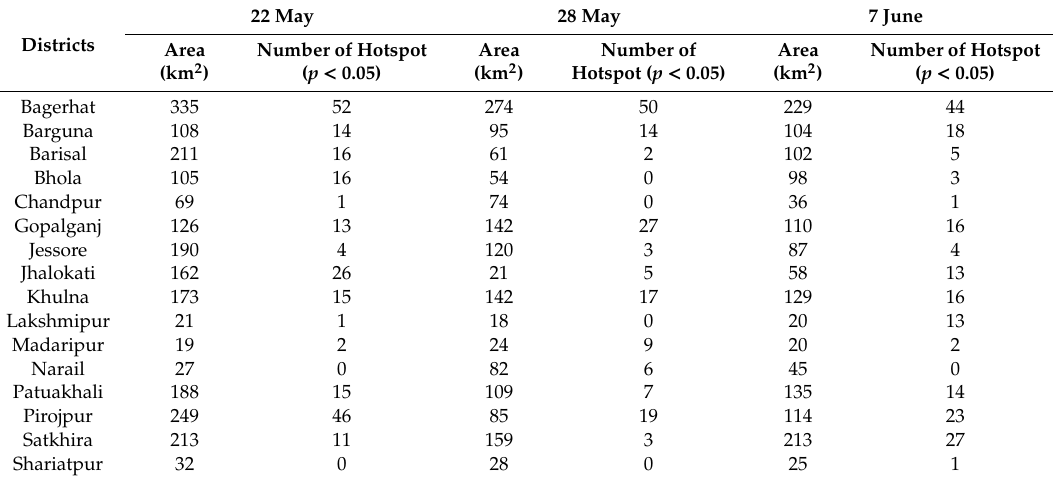
Table 3. Number of flooding hotspots and their corresponding areas by district